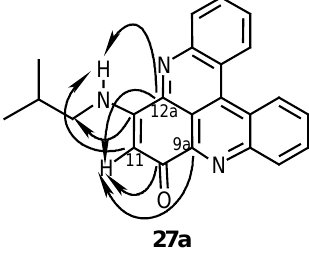
Table 3. Amination products of compounds 24 and 25 with amines R’NH